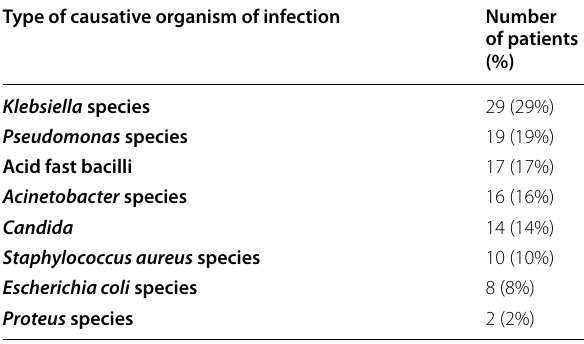
Table 2 Type of causative organism of infection among sepsis cases